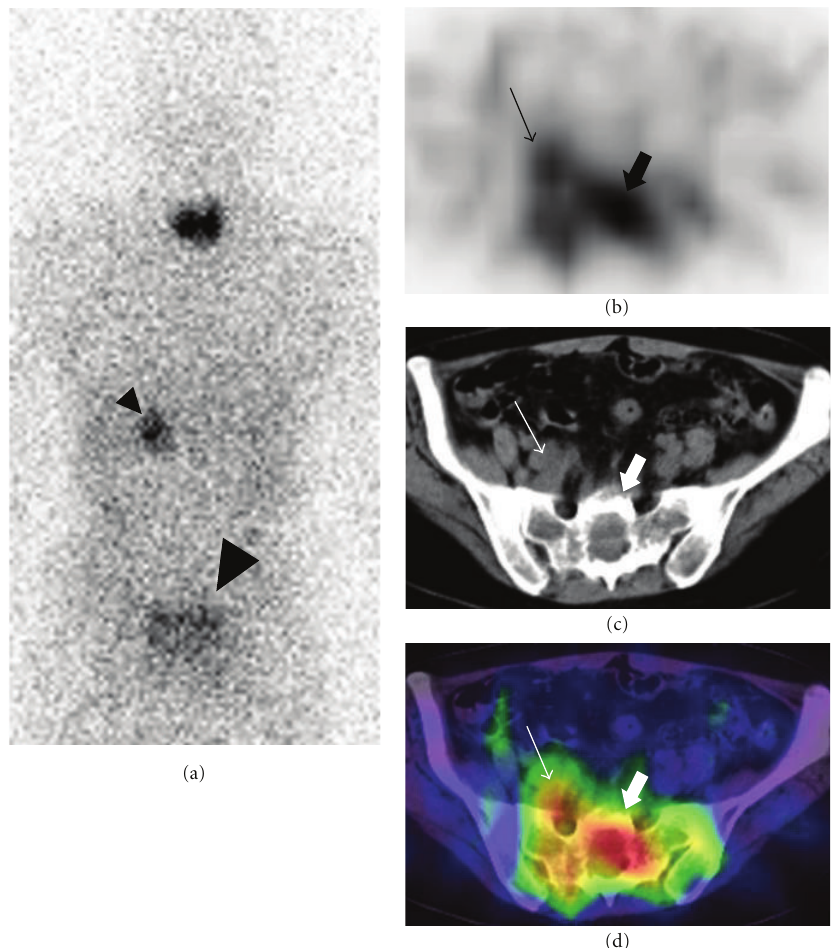
Figure 4: The posterior whole-body adrenocortical scintigraphy image showed focal uptake in the left adrenal (small arrowhead) and pelvic (large arrowhead) lesions (a). The axial SPECT (b), CT (c), and fused SPECT-CT (d) images confirmed increased uptake in the sacrum (thick arrows) and indicated increased uptake in the vein (thin